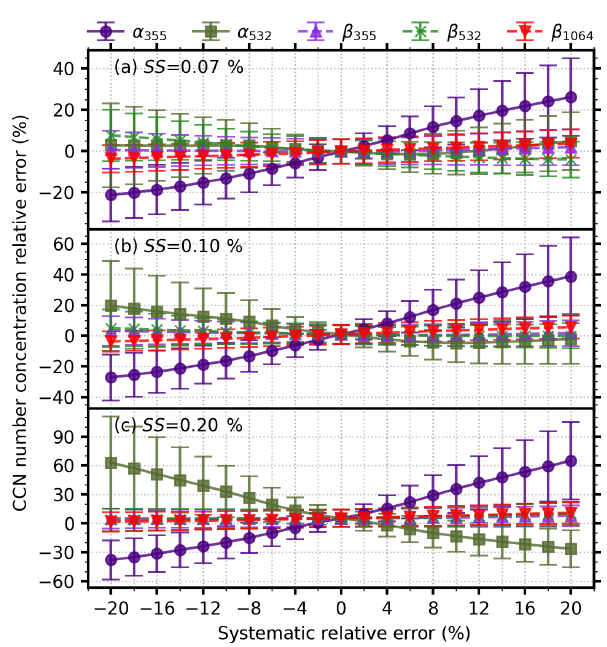
Figure 6. Relative errors in retrieved CCN number concentrations at supersaturations of (a) 0.07%, (b) 0.10%, and (c) 0.20% as a func- tion of systematic errors in backscatter or extinction. The markers are the mean values, and the error bars denote the standard devia- tions.